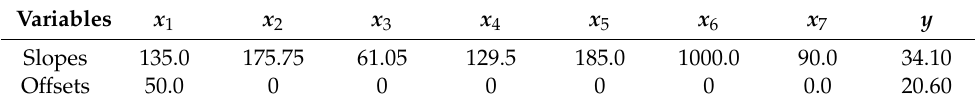
Table 3. Slope and Offset normalization coefficients per variable.